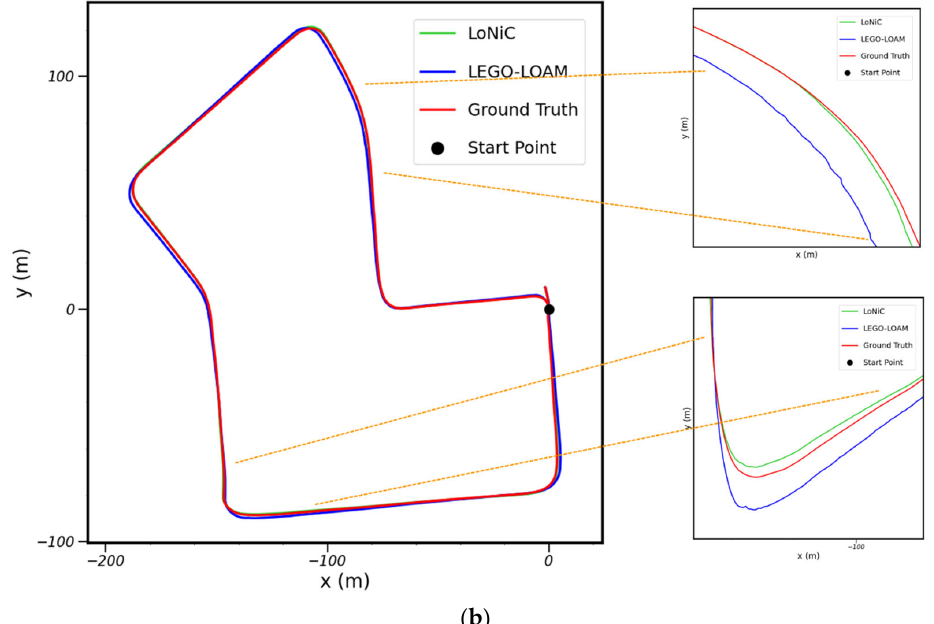
Figure 14. Trajectory comparison: ( a ) trajectory comparison of sequence 05 on the KITTI dataset; ( b ) trajectory comparison of sequence 07 on the KITTI dataset.